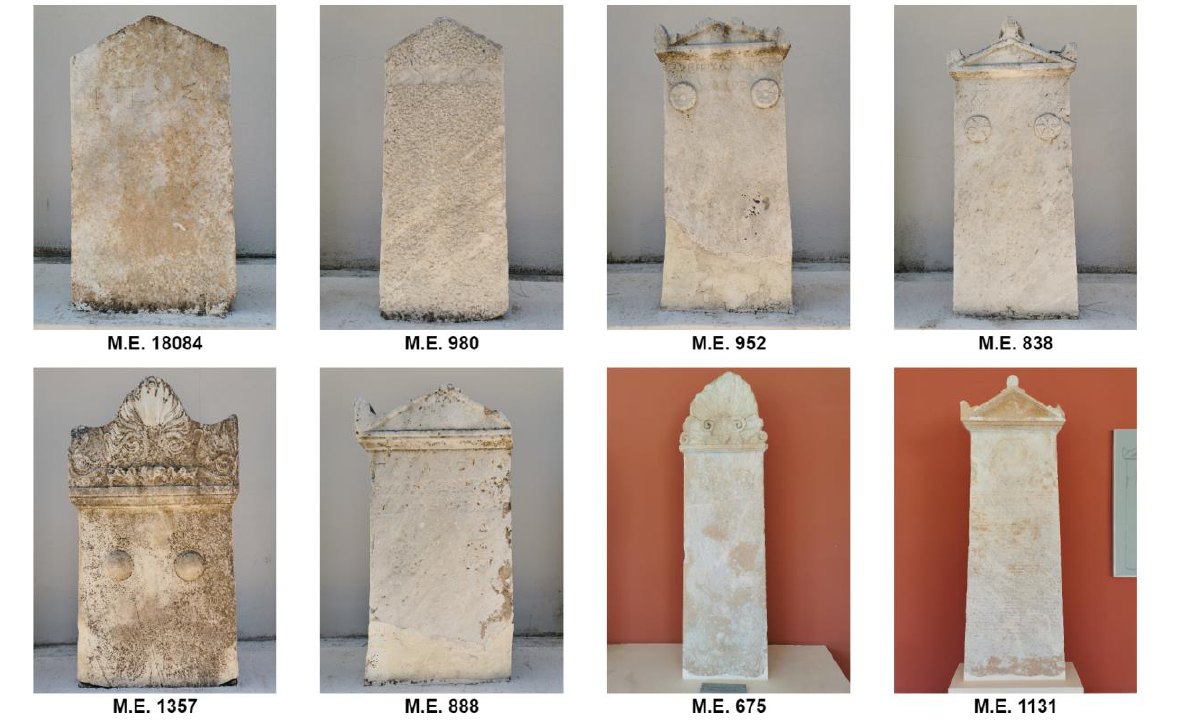
Figure 2. Stelae at the Archaeological Museum of Eretria. All approaches generated results with over 70% accuracy.